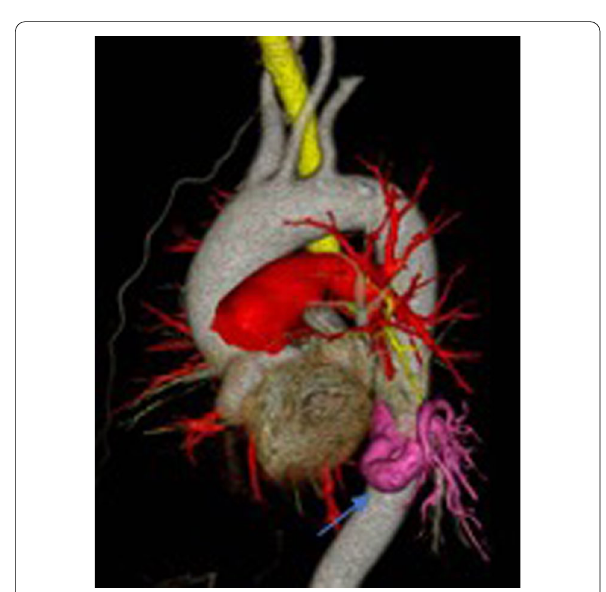
Fig. 2 Three-dimensional CT image of the aberrant artery arising from the descending